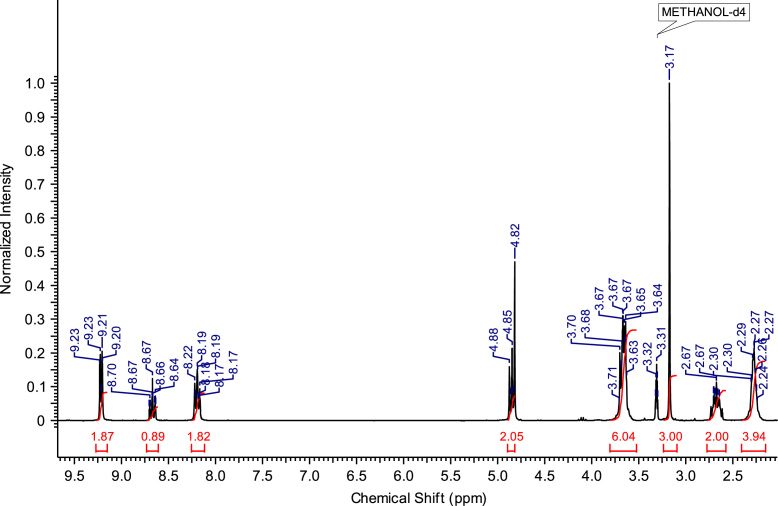
1H NMR spectra of C3(Pyr)(MPyrr)Br2.